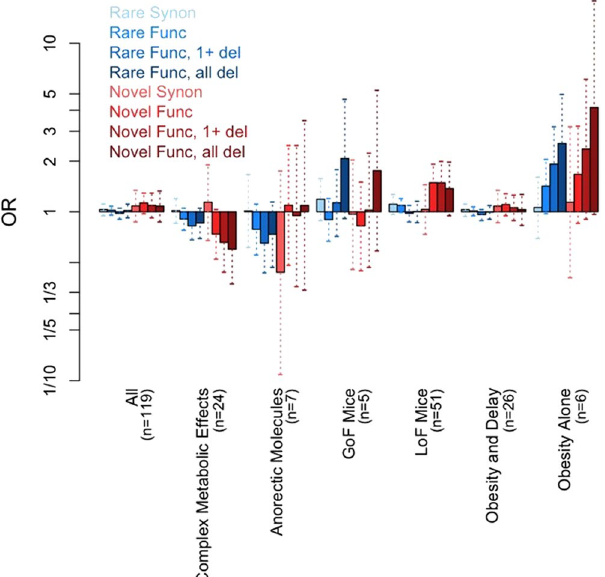
Figure 5. Tiered analysis of obesity candidate genes sets. ORs (bars) and 95% (dotted vertical lines) confidence intervals for each of the six gene tiers and across all 119 genes combined each for eight different filtering scenarios by MAF ( Rare or Novel ) and functional prediction (synonymous - Synon , functional - Func , functional with at least 1 deleterious consequence prediction – Func , 1 + del , and functional with all deleterious consequence predictions - Func , all del